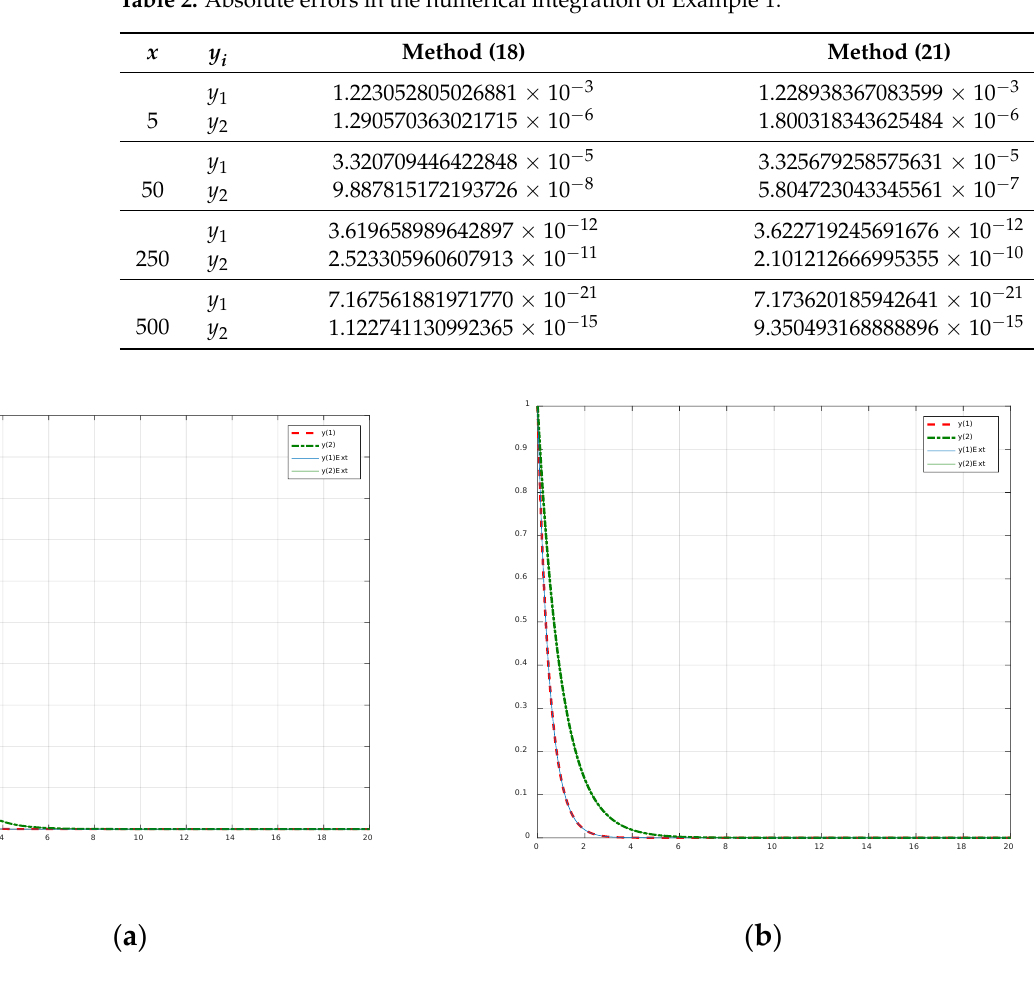
Figure 3. Graphical plots of Example 1 using block hybrid methods with nfe = 500. ( a ) Solution curve of Example 1 using (18); ( b ) solution curve of Example 1 using (21).